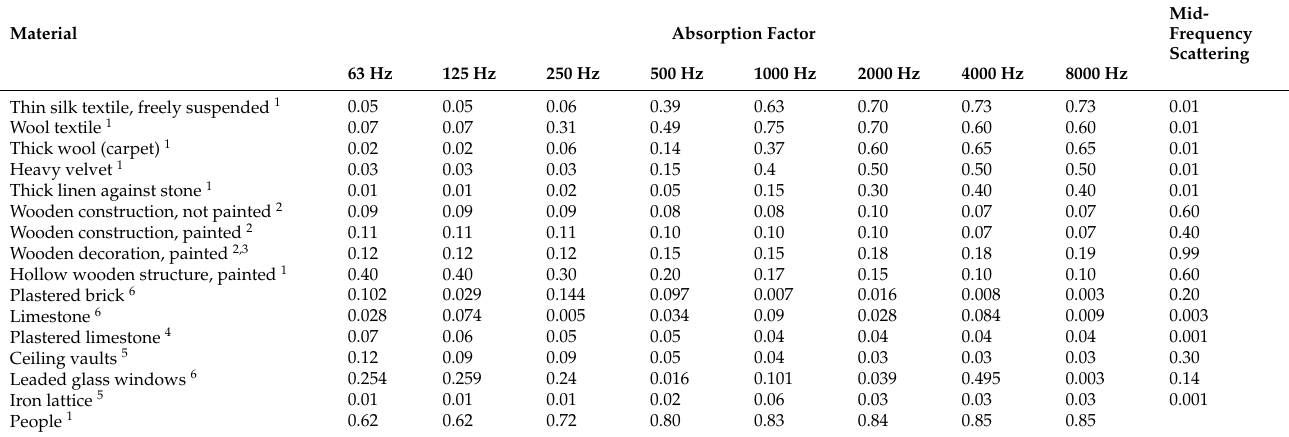
Table A1. Material coefficients used for the room acoustic simulations and auralization of the reconstructed abbey.